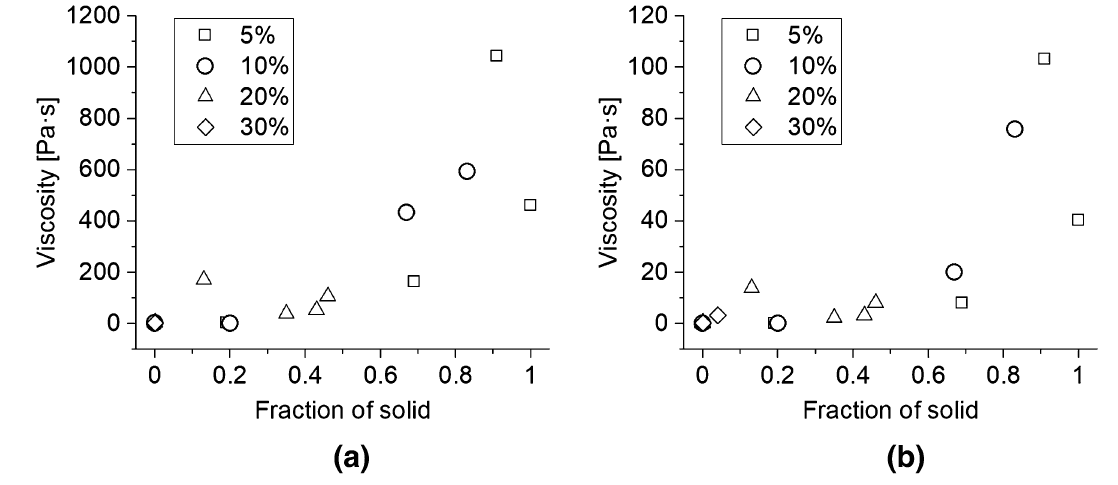
Fig. 5 Rotational viscosity measurements plotted against fraction of solid at a shear rate of a 1 s −1 and b 10 s −1 for 5, 10, 20 and 30% Cu (by weight) in Al